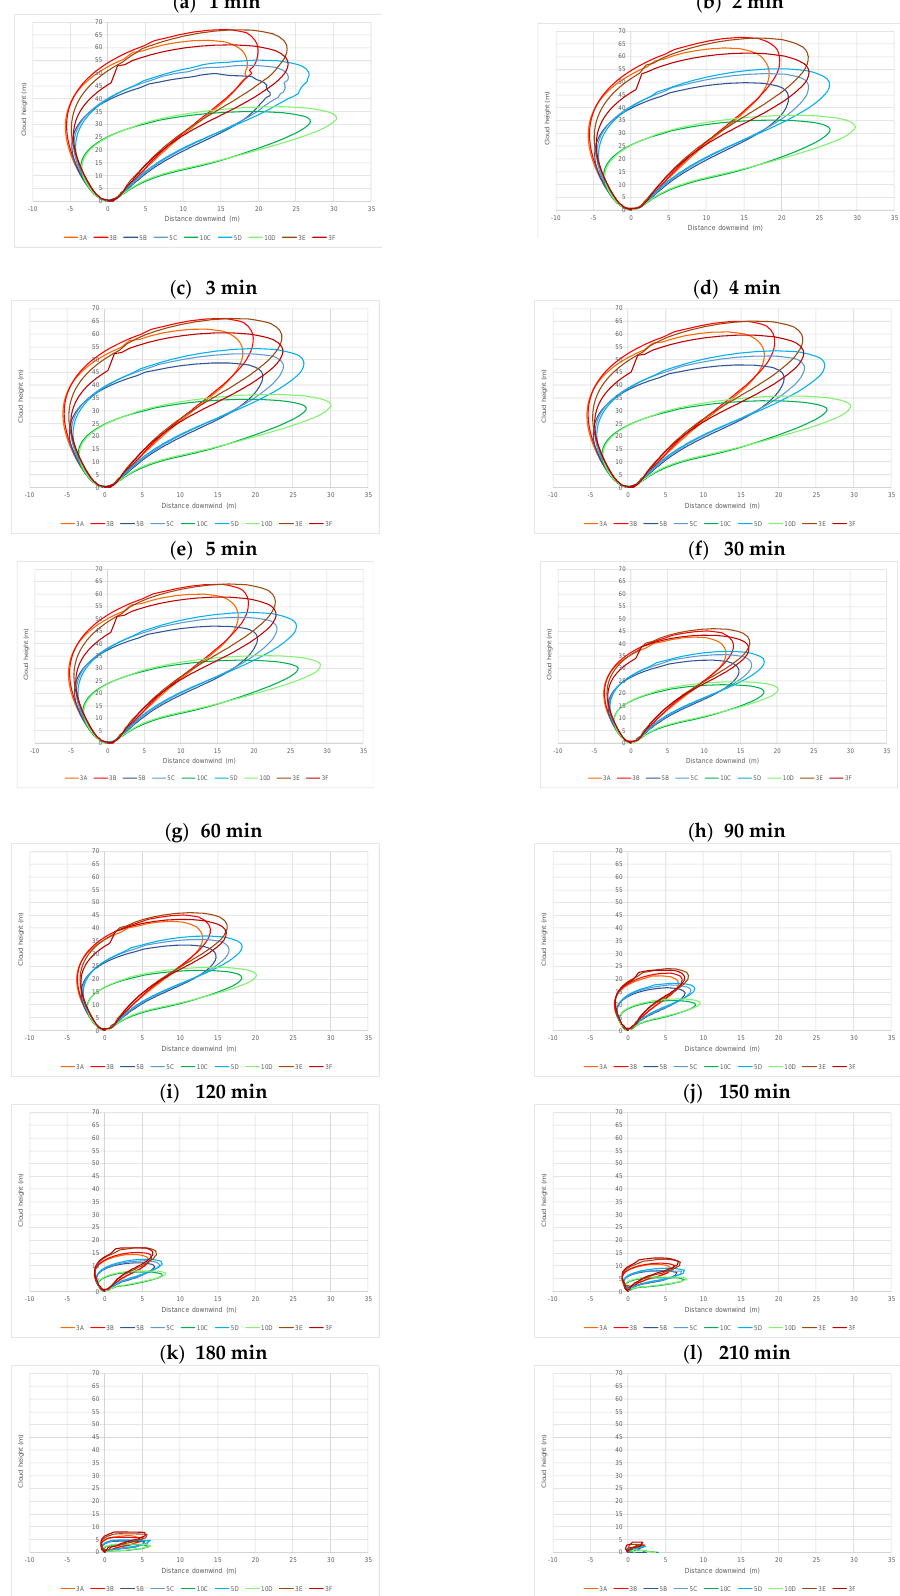
Figure 5. Evolution of the hydrogen plume formed by a leak in the EZ53 salt cavern (contours: lower flammability limit of hydrogen, i.e., 40,000 ppm).